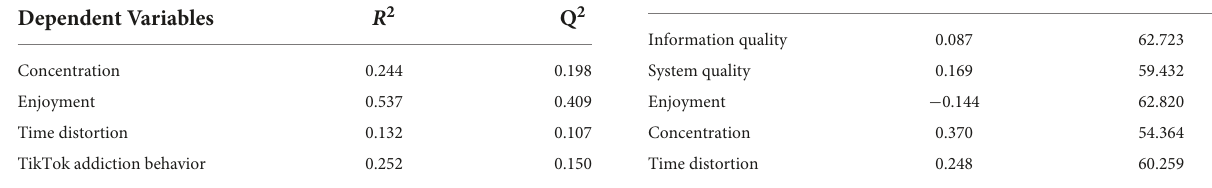
TABLE 7 Model results for R 2 and Q 2 .